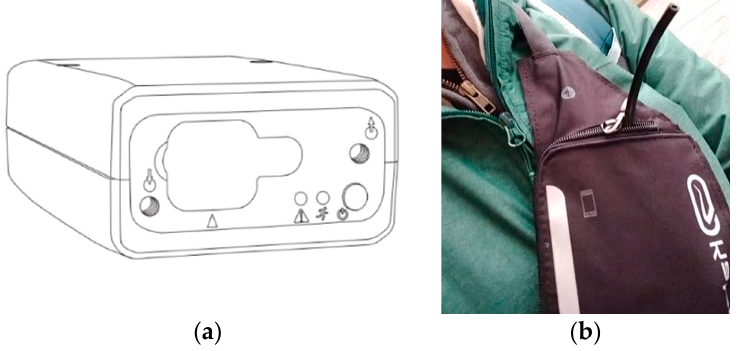
Figure 3. ( a ) Micro-aethalometer AE51 (Aethlabs-San Francisco, CA, USA). ( b ) Equipped shoulder bag with the sampling tube worn by